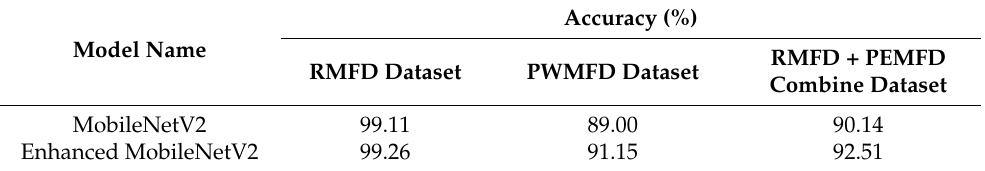
Table 5. Enhanced MobileNetV2 compared with MobileNetV2 against different datasets.